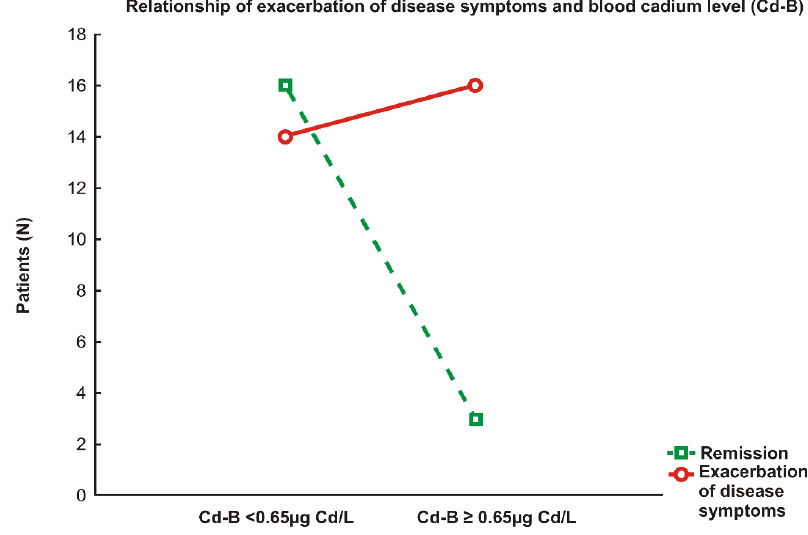
Figure 1. Relationship between the exacerbation of inflammatory arthritis (IA) symptoms and high blood cadmium concentrations (Cd ‐ B ≥ 0.65 μ g/L).